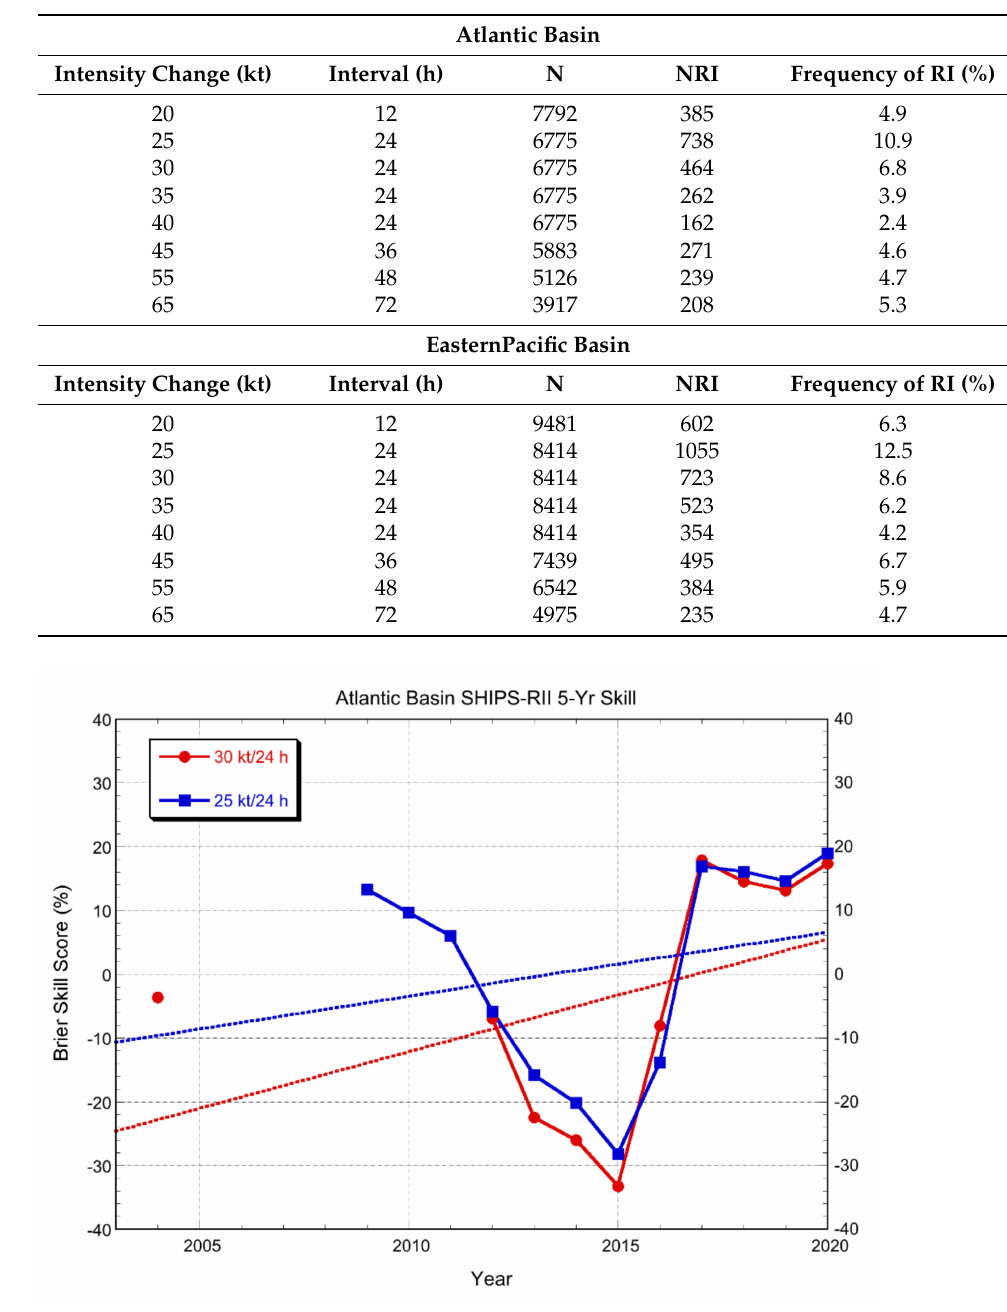
Figure 4. Brier skill score (%) of Atlantic basin SHIPS-RII forecasts for two RI thresholds (30 kt/24 h and 25 kt/24 h). Each point on the diagram represents a 5-yr sample of forecasts ending at the year indicated, except for the 2004 entry, which represents a 4-yr sample. Linear best-fit lines are given by the dashed lines. Note that the trend lines extend back to the start of the periods represented by the data points. The blue trend line is extended back to the start of the red trend line for